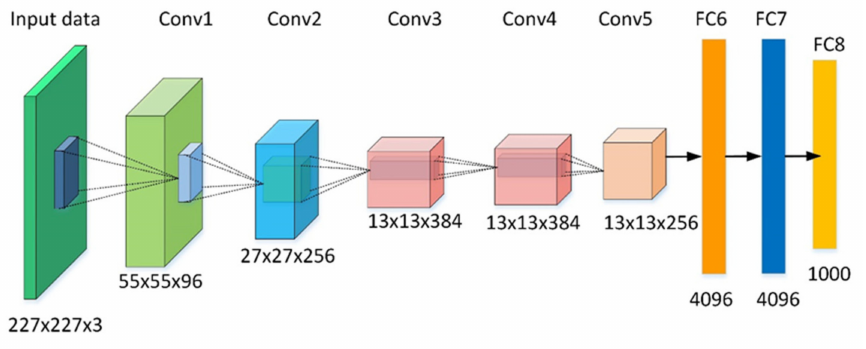
Figure 2. The architecture of